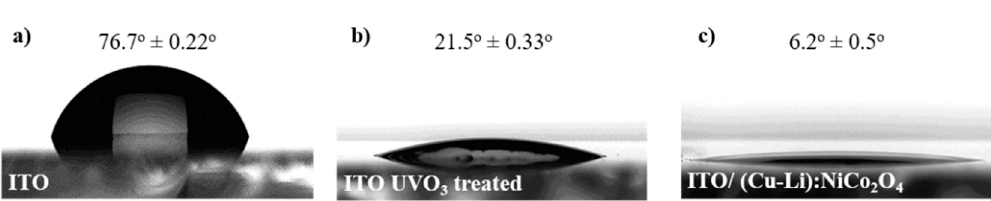
Figure 1. Static contact angle (CA) of deionized water droplet images on different substrates, ( a ) un-modified ITO, ( b ) ITO exposed to 5 min UVO 3 surface treatment, ( c ) ITO/(Cu-Li):NiCo 2 O 4 .